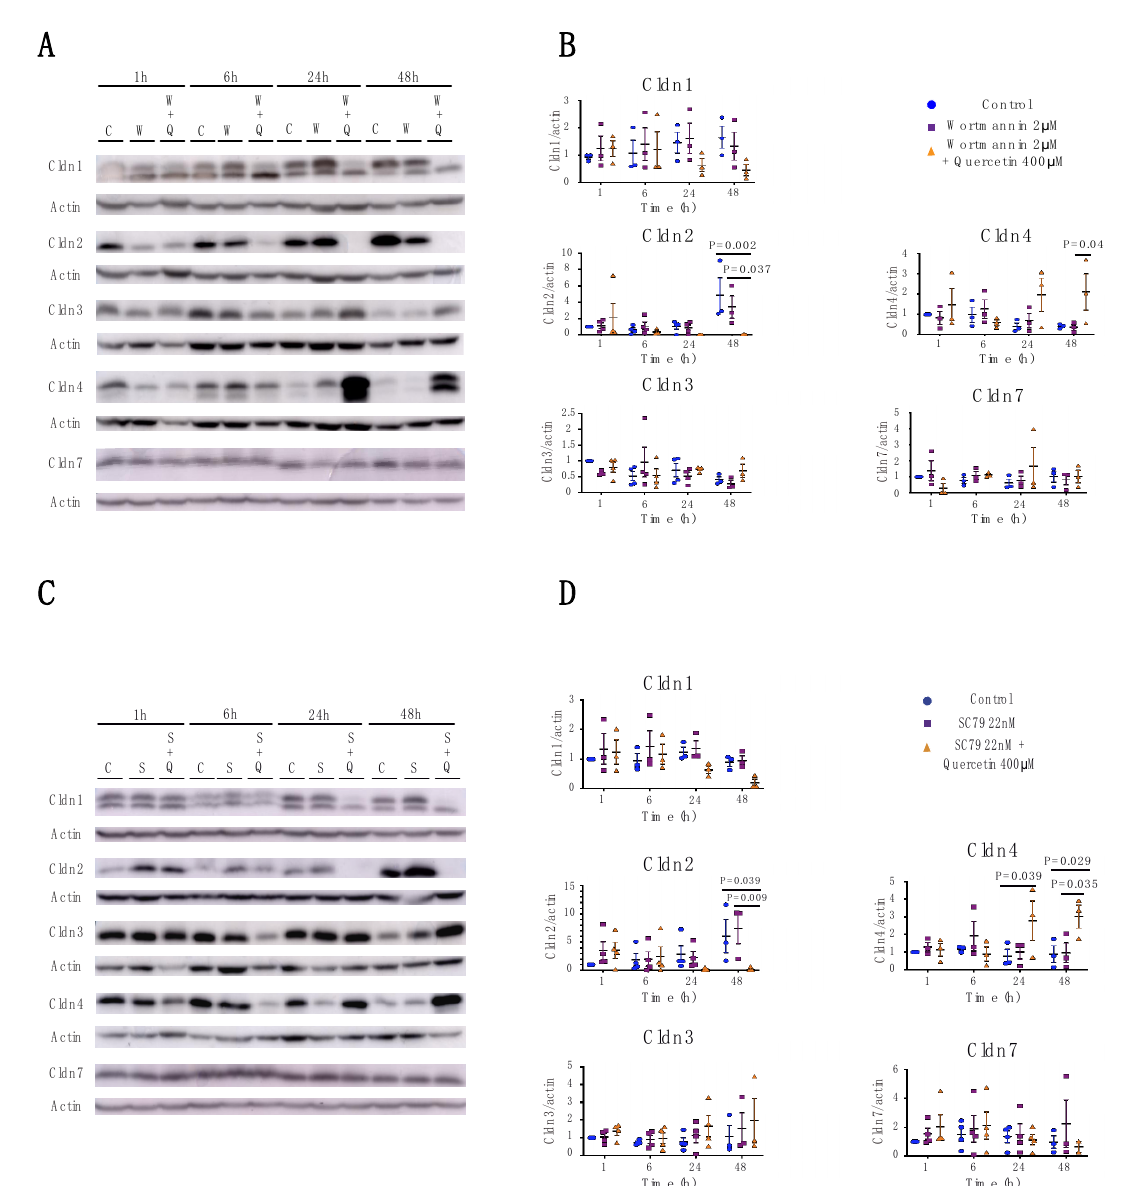
Figure 8. Analysis of Cldn1, -2, -3, -4, and -7 expression in MDCK II cells following wortmannin or SC79 treatment. ( A ) Western blot analysis of claudin expression in cell lysates from control, 2 µ M wortmannin-treated and 2 µ M wortmannin plus 400 µ M quercetin-treated MDCK II cells. Actin was used as a loading control. ( B ) Densitometry measurements of band intensity on western blot were normalized to control at 1 h and protein expression was plotted relative to normalized actin expression. Cldn1 (P int = 0.6; P time = 0.98; P treat = 0.24), Cldn2 (P int = 0.059; P time = 0.016; P treat = 0.097), Cldn3 (P int = 0.29; P time = 0.26; P treat = 0.78), Cldn4 (P int = 0.21; P time = 0.97; P treat = 0.041), and Cldn7 (P int = 0.41; P time = 0.98; P treat = 0.83) measurements were plotted. ( C ) Western blot analysis of claudin expression in cell lysates from control 22 nM SC79-treated and 22 nM SC79 plus 400 µ M quercetin-treated MDCK II cells. Actin was used as a loading control. ( D ) Densitometry measurements of band intensity on western blot were normalized to control at 1 h and protein expression was plotted relative to normalized actin expression. Cldn1 (P int = 0.6; P time = 0.15; P treat = 0.11), Cldn2 (P int = 0.09; P time = 0.14; P treat = 0.11), Cldn3 (P int = 0.99; P time = 0.46; P treat = 0.21), Cldn4 (P int = 0.082; P time = 0.73; P treat = 0.047), and Cldn7 (P int = 0.87; P time = 0.78; P treat = 0.5) measurements were plotted. Each point corresponds to an independent experiment; mean and SEM are shown. W = Wortmannin; S = SC79; C = Control; and Q =